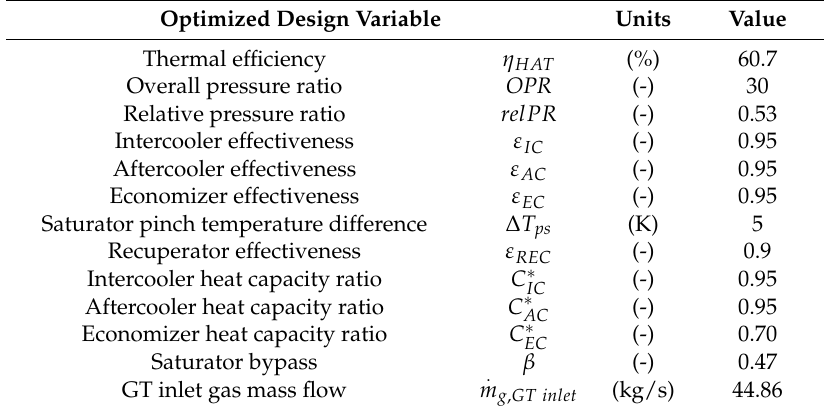
Table 6. Design variables values of the baseline cycle A 30 with maximum thermal efficiency.